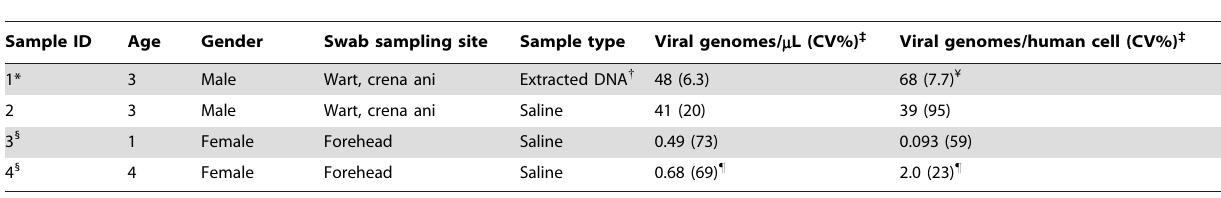
Table 1. Characteristics of HPV154 positive children and viral loads in swab